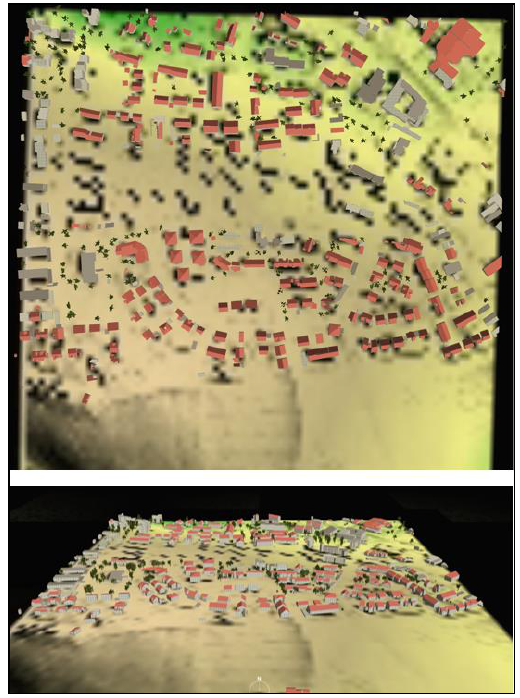
Figure 4. From top and side view of 3D models A closer view of the models is given in Figure 5.